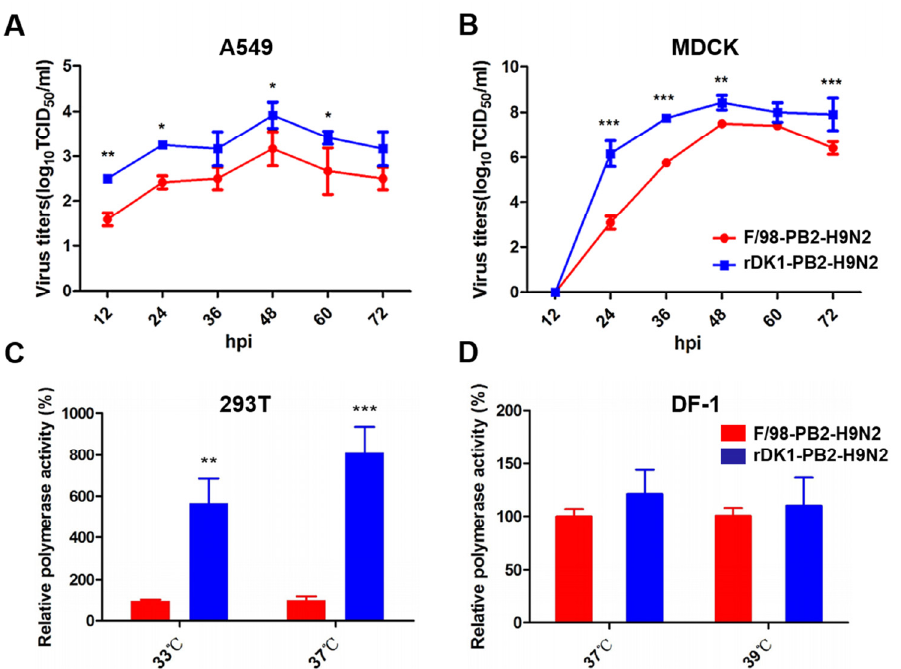
Figure 1. DK1-like PB2 enhances the replication ability and polymerase activity of H9N2 viruses in mammalian cells. Two strains of rDK1-PB2-H9N2 and F/98-PB2-H9N2 infected ( A ) A549 cells and ( B ) MDCK cells with MOI = 0.1, respectively, and cell supernatants were collected at 12, 24, 36, 48, 60, and 72 h post-infection to determine viral titers using the TCID 50 assays; PB1, PA and NP proteins were co-transfected with DK1-like PB2 protein or F/98-like PB2 protein into ( C ) 293T or ( D ) DF-1 cells, respectively. After transfection, the polymerase activity was detected after culturing at differ- ent temperatures for 24 h. The polymerase activity of the F/98-like PB2 protein group was set as 100%, and the polymerase activity value of the DK1-like PB2 protein group was a percentage rela- tive to the polymerase activity value of the F/98-like PB2 protein group. Shown in the figure are the mean ± SD of the results of 3 experiments. Differences were considered statistically significant at p < 0.05 (* p < 0.05, ** p < 0.01, and *** p < 0.001, ANOVA).